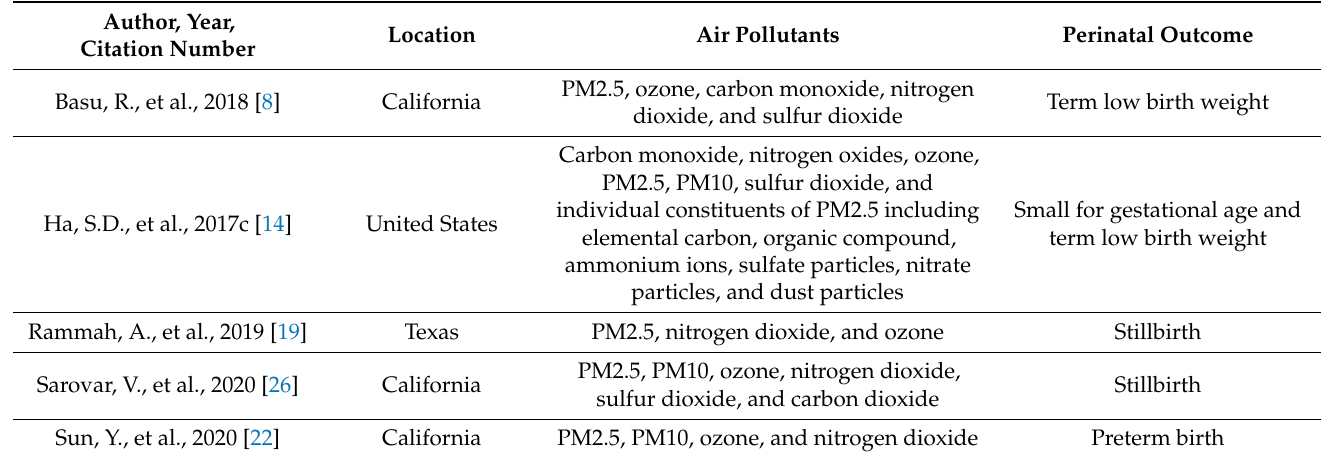
Table 3. Air Pollution Exposure Studies ( n = 5).